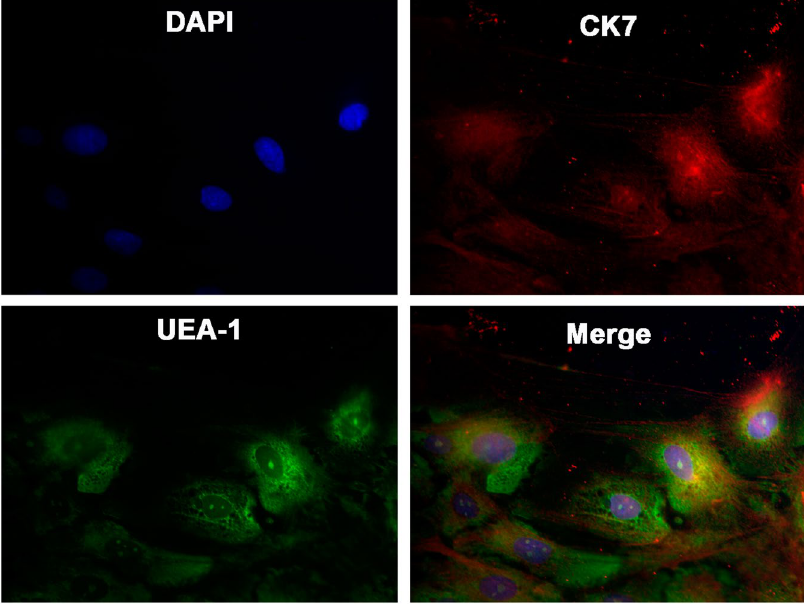
Figure 1. Representative images of rat cultured conjunctival goblet cells. Nuclei were stained in blue with DAPI. CK7 localization is indicated in red and lectin UEA-1 in green. Magnification